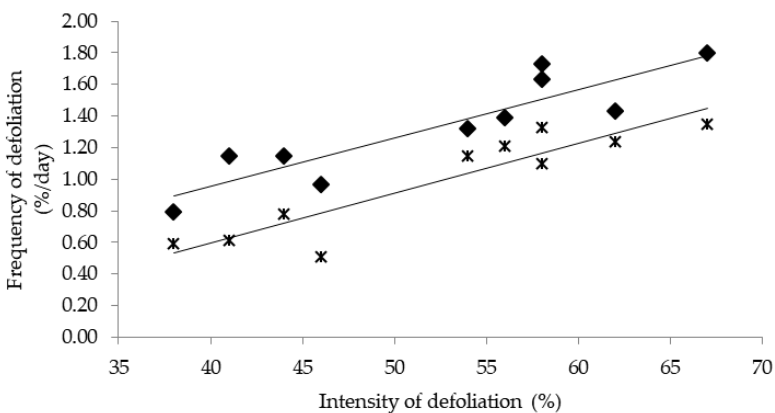
Figure 1. Relationship between frequency of defoliation of individual tillers and stocking density in kikuyugrass pastures subjected to different intensities of defoliation (y = 0.54x − 1.05; R 2 = 0.80).